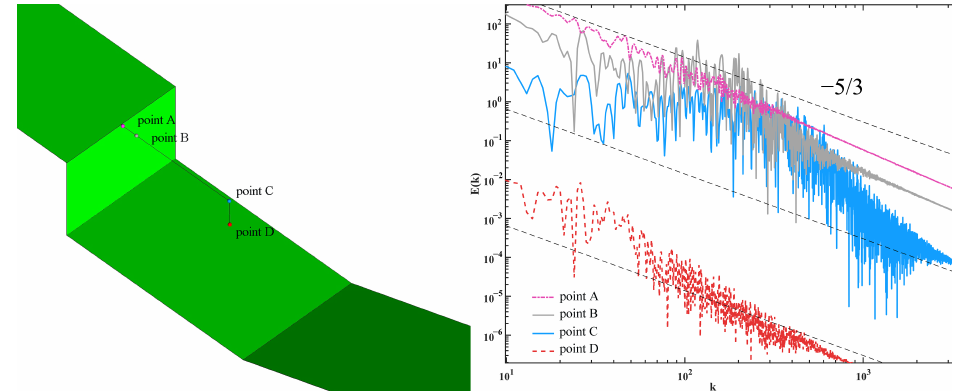
Figure 10. Turbulent energy spectrum obtained by sampling over time the k value in various locations of the